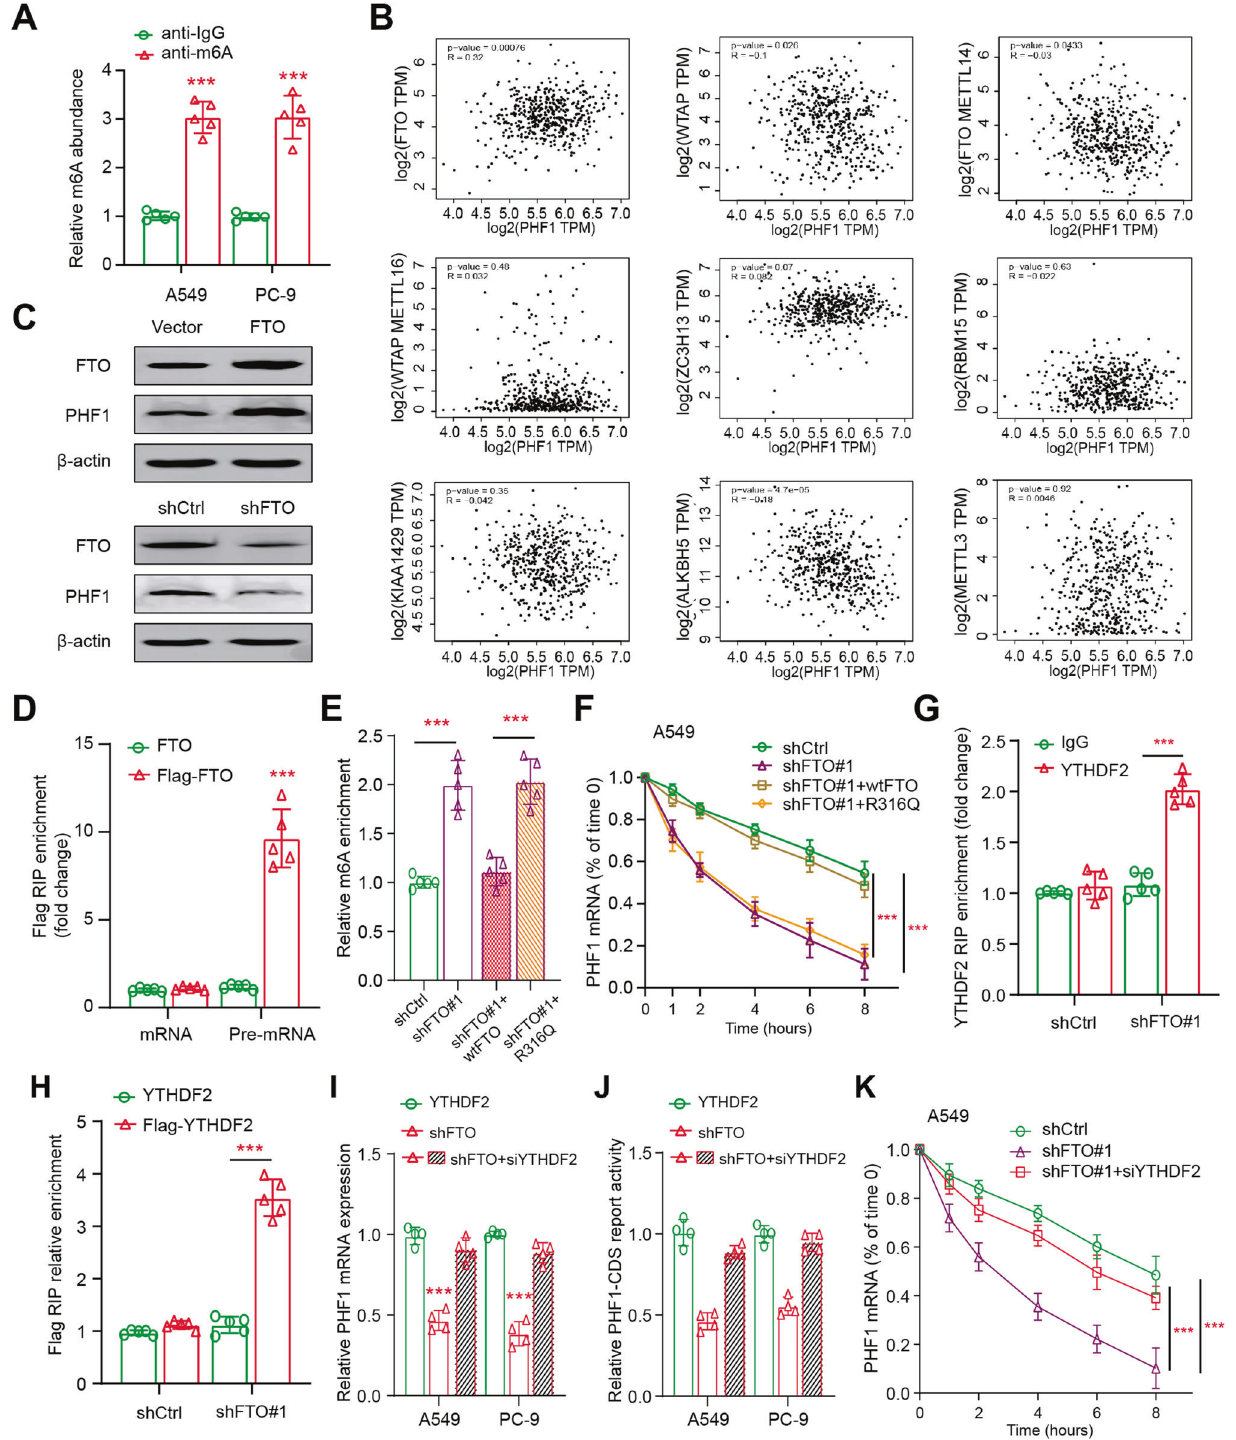
dependent m6A demethylation (Fig. 3E). Given that m6A modi fi cation on transcripts mainly contributes to stability and degradation of mRNA, we found that PHF1 mRNA was destabilized when RNA synthesis was suppressed by actinomycin D in FTO- knockdown A549 cells (Fig. 3F). Particularly, the impaired PHF1 mRNA stability could only be restored by overexpressing wild-type FTO, but not the defective R316Q mutant in FTO-KD cells (Fig. 3F). As is well documented, YT521-B homology domain family (YTHDF)